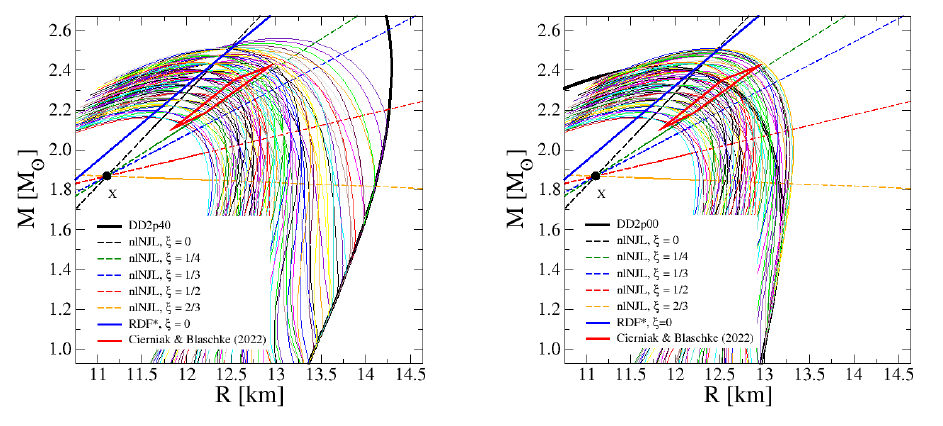
Figure 3. Mass-radius relation for all hybrid stars obtained by a Maxwell construction. Dashed lines connect special points with a fixed slope ξ = δη V / ( δη D ) of simultaneous variation of the Lagrangian parameters and meet in one point denoted as X. The lines remain unchanged when the hadronic EOS is changed from the sti ff DD2p40 EOS (left panel) to the softer DD2p00 EOS (right panel). For a comparison, we show the red trapezoidal region that is enclosed by the upper and lower limits of the parameter A (long edges) and the upper and lower limits of the constant speed of sound (short edges) of the CSS fit to the nlNJL EOS [11]. The bold blue line is obtained from the confining RDF model with conformal limit [15] for ξ = 0, see section